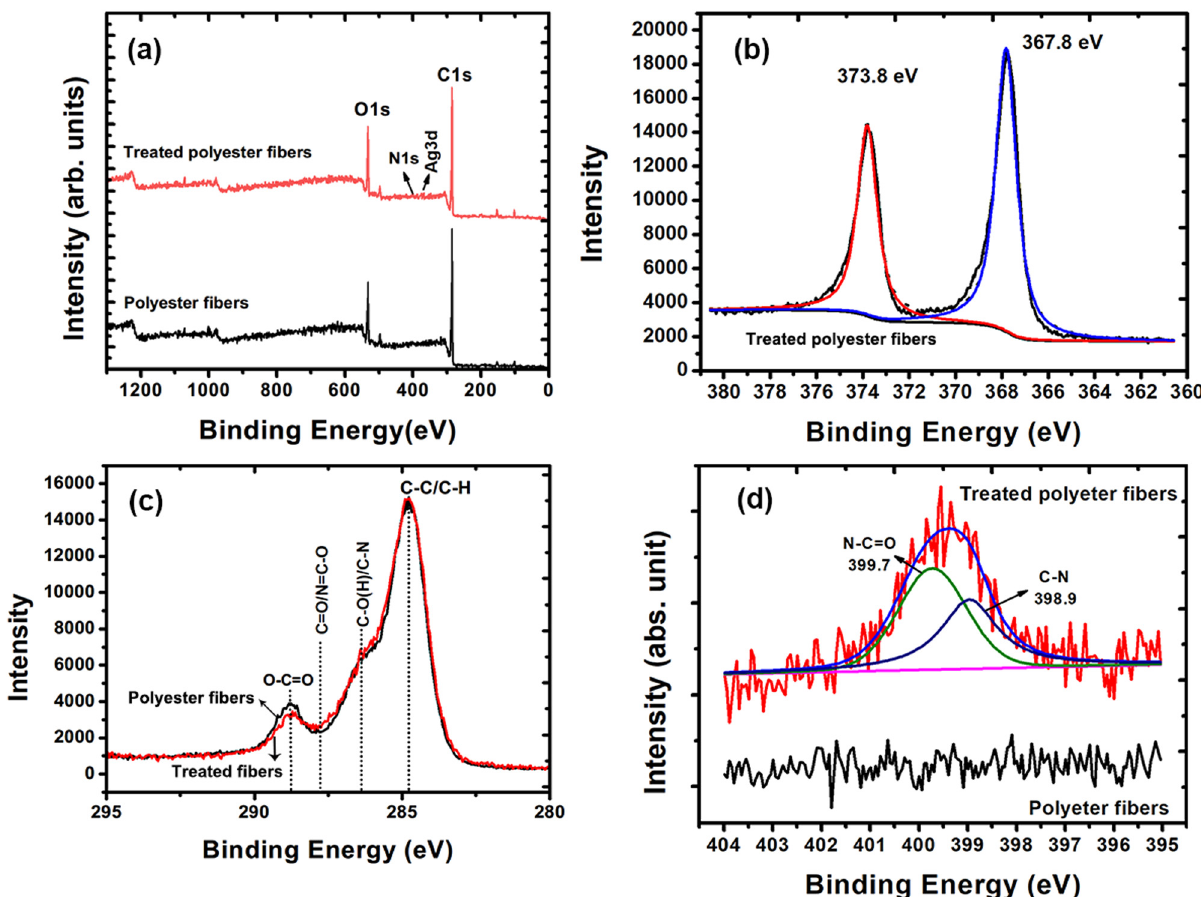
Figure 6: ( a ) Wide - scan, ( b ) Ag 3d, ( c ) C1s, and ( d ) N1s XPS spectra of pure and/or treated polyester fi